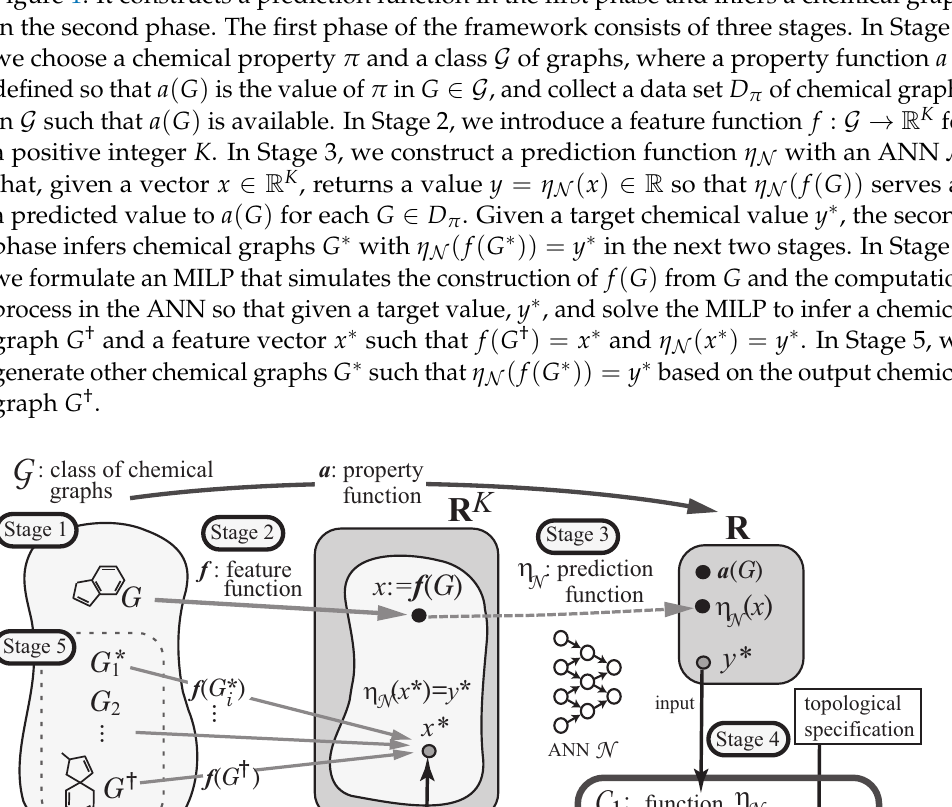
the acyclic chemical compounds in the